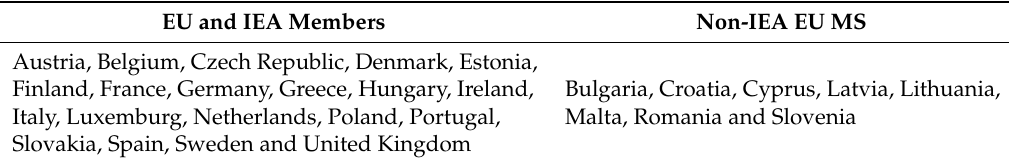
Table 1. EU and IEA MS in 2016 (based on IEA [9]). EU and IEA Members Non-IEA EU